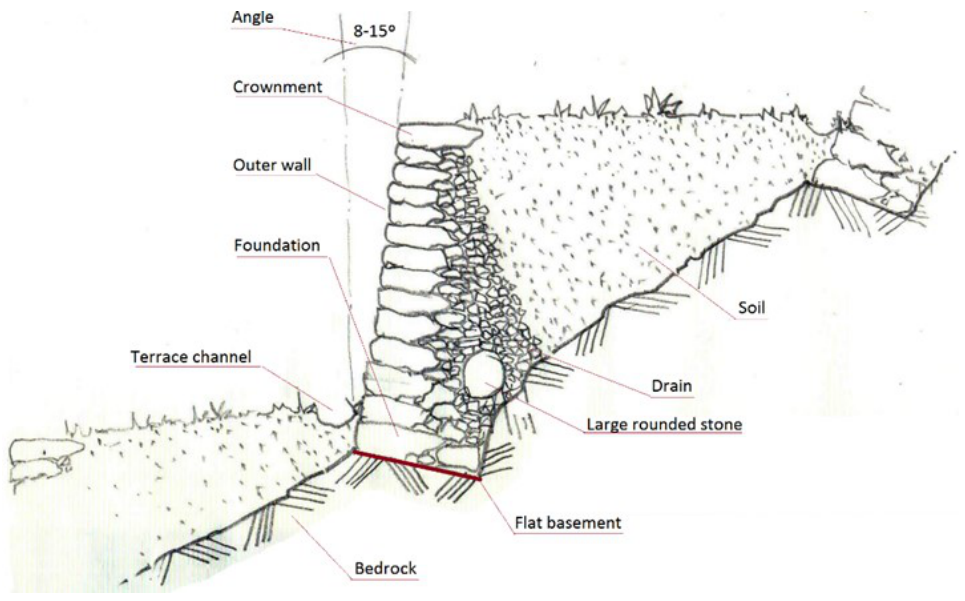
Figure 6: General scheme of a support dry stone